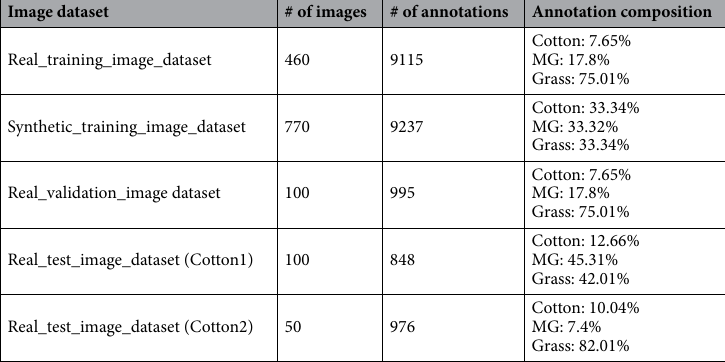
Table 2. Details on training, validation, and test datasets used in this study.